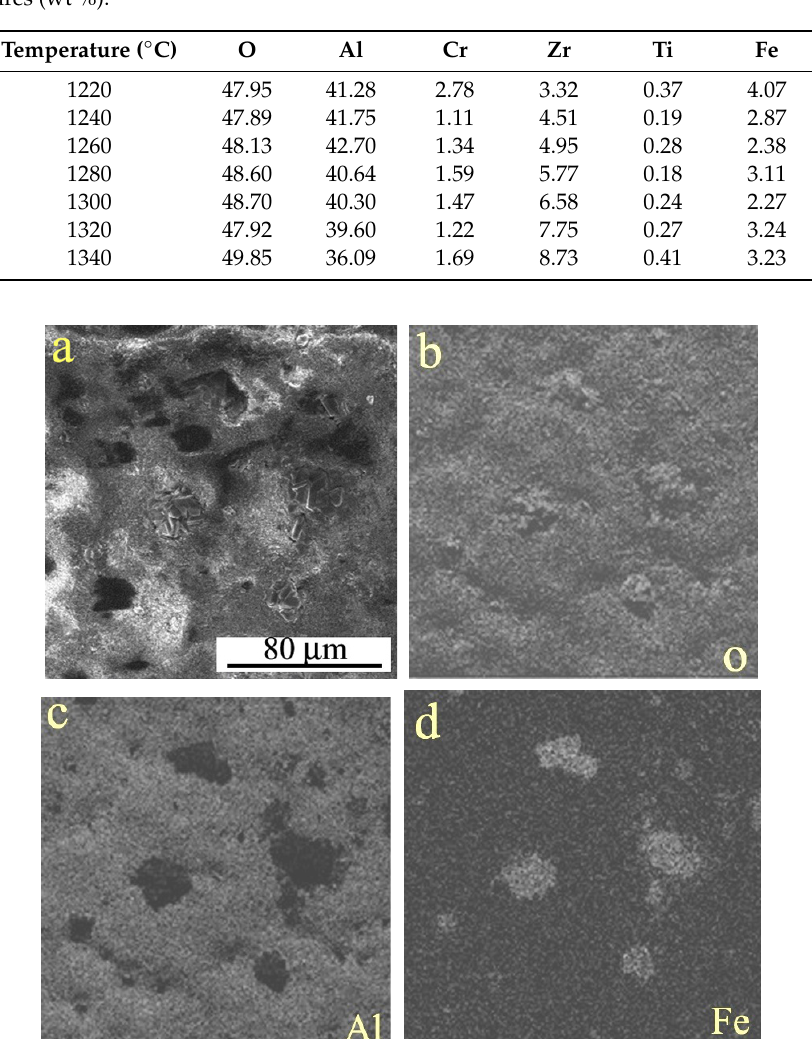
Figure 5. Scanning electron microscope (SEM) image and elemental mappings of surface oxidzed at 1340 °C for 3 h: ( a ) SEM image, ( b ) O, ( c ) Al, ( d ) Fe.